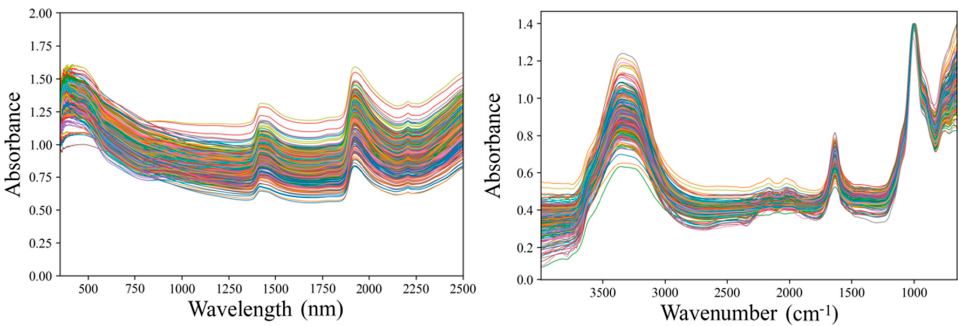
Figure 5. In situ vis-NIR ( left , ABS+SG) and MIR ( right , SG+MAN) spectra.